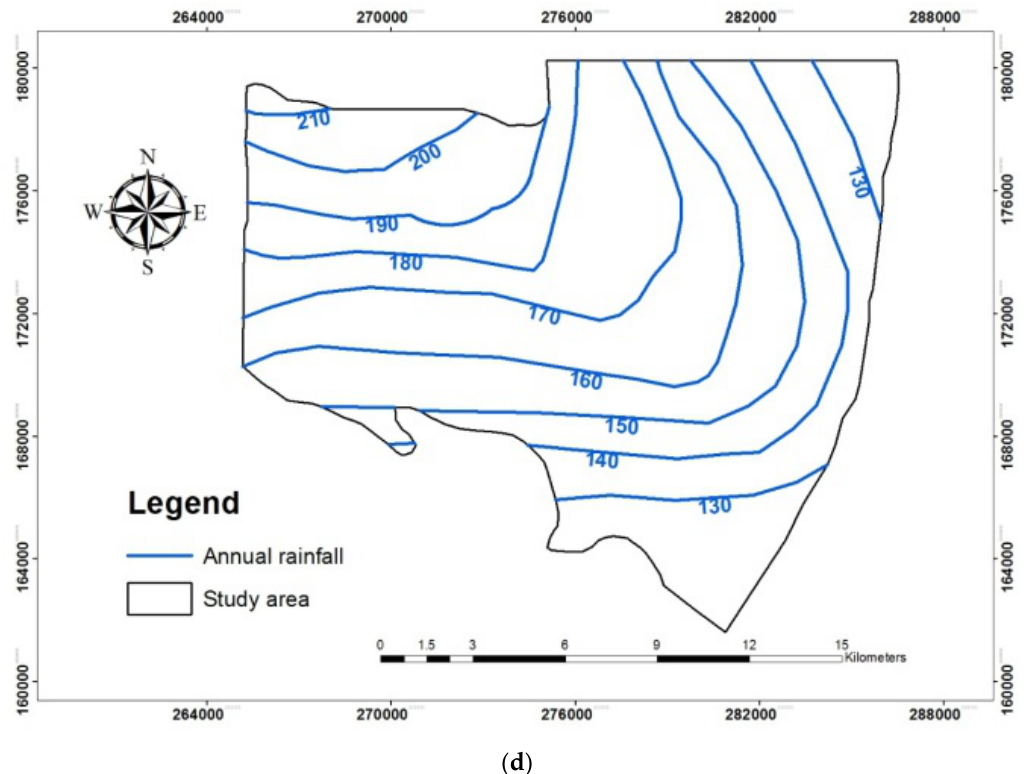
Figure 4. ( a ) Topographical map. ( b ) Base map of B2/A7. ( c ) Boundary conditions. ( d ) The long-term average of rainfall.